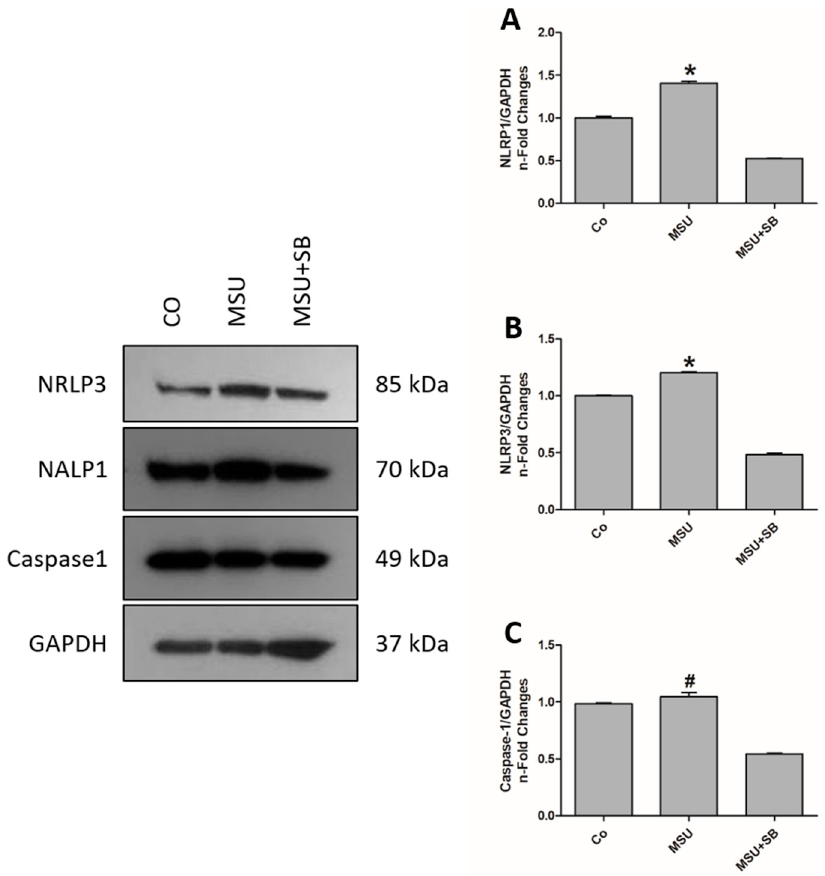
Figure 7. NLRP1 ( A ), NLRP3 ( B ) and Caspase-1 ( C ) protein expression by THP-1 cells cultured in the absence (Co) or presence of MSU or silibinin (SB). Results, obtained from five independent experiments, are shown as mean ± SD in arbitrary units (a.u.). * p < 0.05 vs. Co, MSU + SB; # p < 0.05 vs. MSU + SB (ANOVA) .